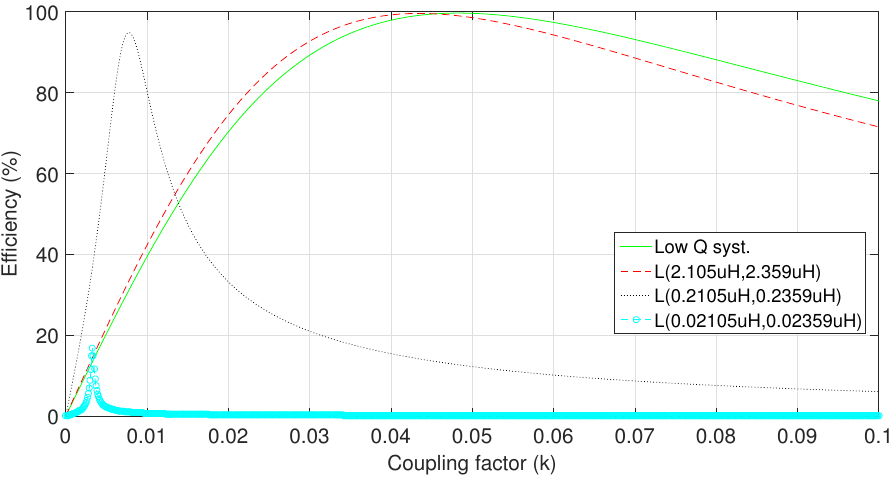
Figure 7. The effect of the different values of additional inductors on the coupling factor needed to reach maximum efficiency. The coupling factor needed to reach maximum efficiency drops with the decrease of the value of additional inductor.